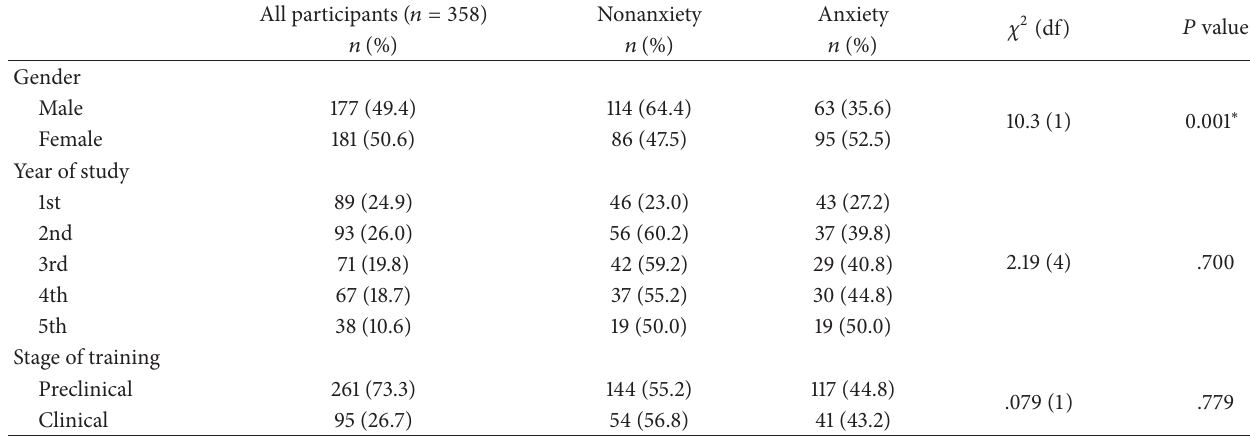
Table 3: Relationship between gender, year of study, and stage of training (clinical and non-clinical) with existence or nonexistence of anxiety. All participants ( 𝑛 = 358 )